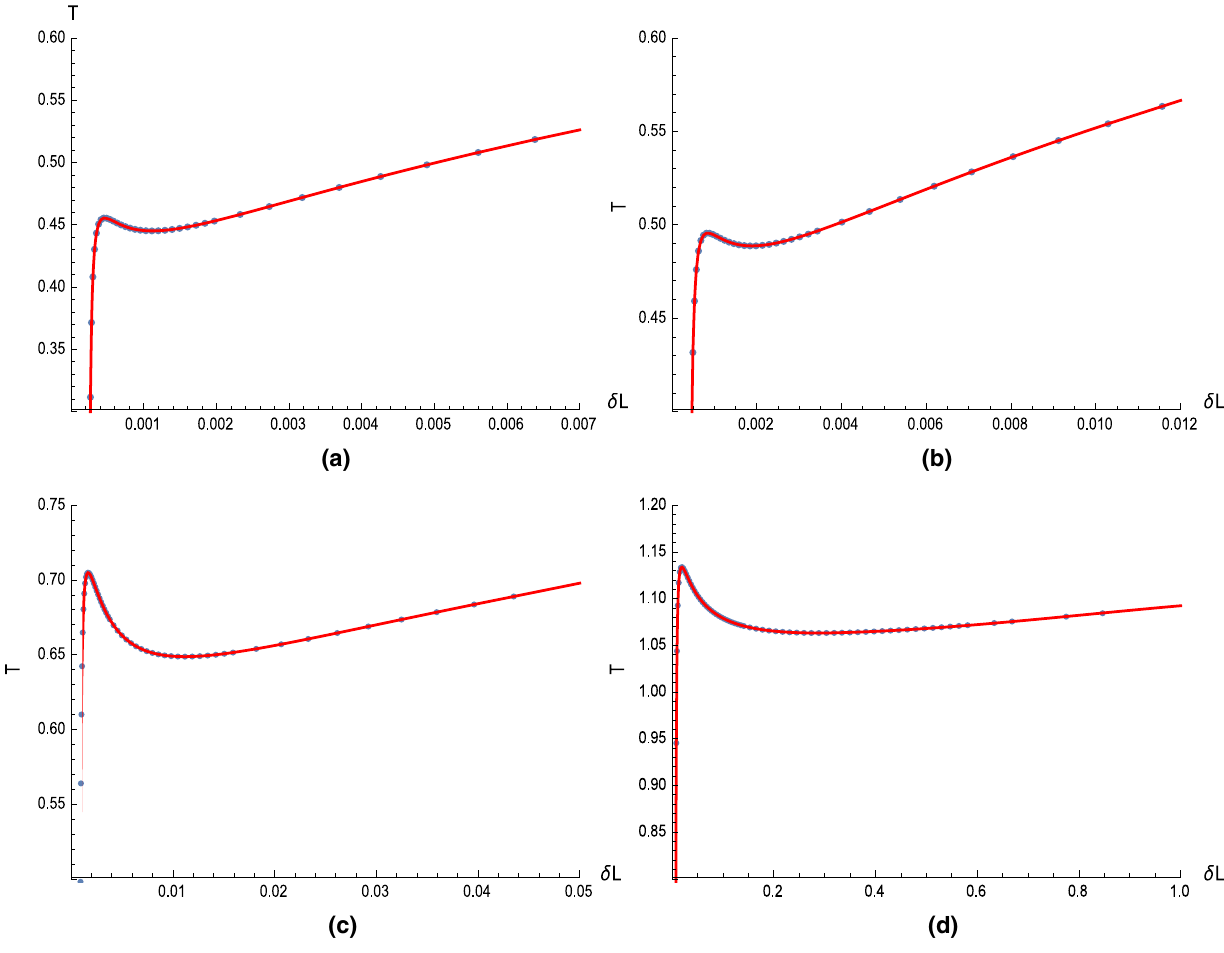
Fig. 4 T vs. δ L for n = 4 ,θ 0 = 0 . 3. a α = 0 , q = 0 . 12, b α = 0 . 25 , q = 0 . 12, c α = 0 . 5 , q = 0 . 06, d α = 0 . 75 , q = 0 .